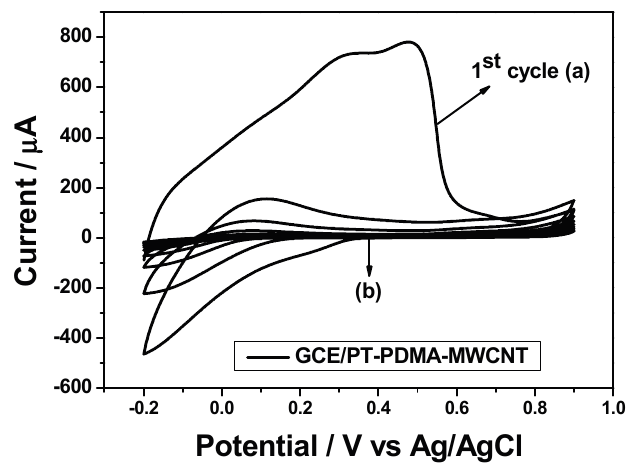
Figure 4. Cyclic voltammograms of GCE/PT-PDMA-MWCNT in PBS: (a) immediately after electrosynthesis and (b) after conditioning (cycling until equilibration of voltammetric current).